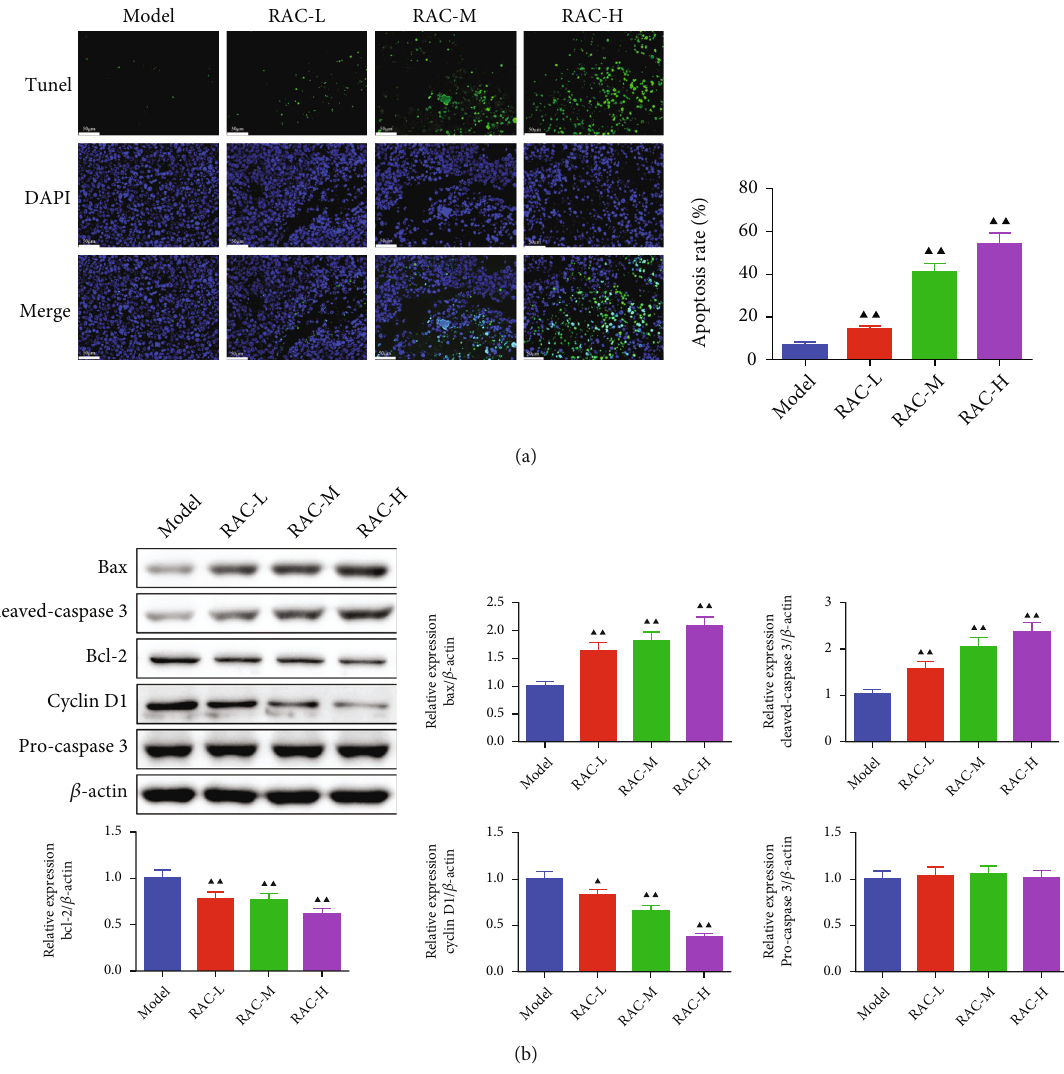
Figure 6: RAC induced the apoptosis of the tumor tissue in RCC mice. (a) The apoptosis was measured by TUNEL. (b) The protein expression of Bax, Cleaved-caspase 3, Bcl-2, and Cyclin D1 was detected by western blot. ▲ P < 0 : 05 and ▲▲ P < 0 : 01 vs. the model. Results were presented as mean ± SD . n = 3 . Note: RAC: Radix Actinidia chinensis; RCC: renal cell carcinoma; TUNEL: terminal deoxynucleotidyl transferase dUTP nick end